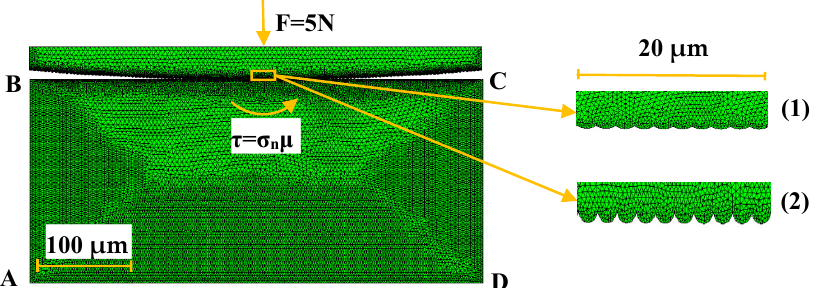
Figure 17. The computational domain with the applied finite element mesh and different counterpart roughness levels: (1) R a = 0.1 μ m, (2) R a = 1 μ m.